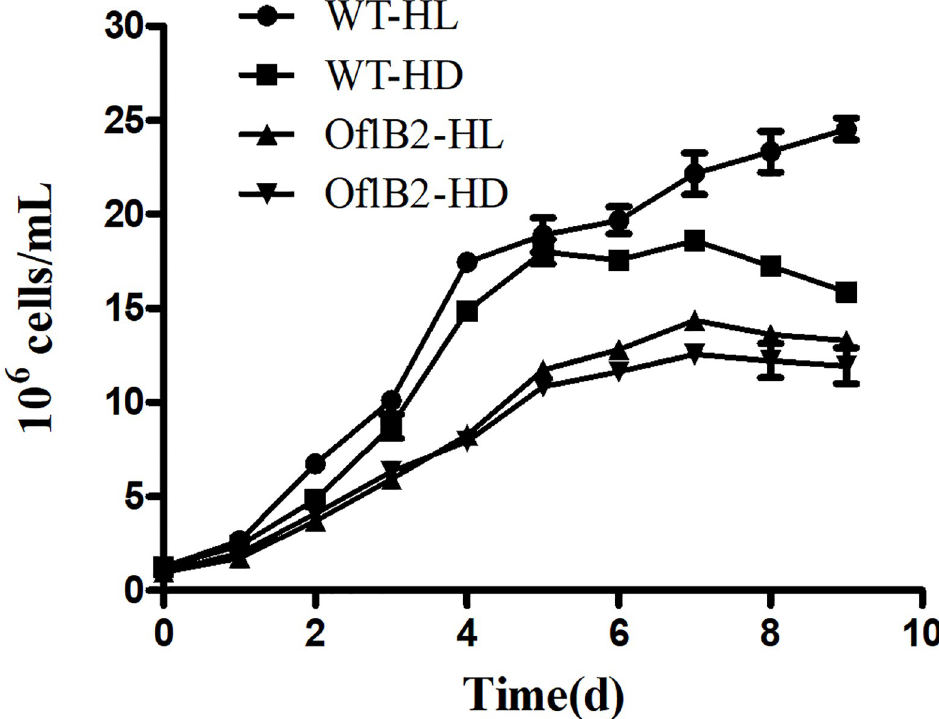
Fig 1. The growth of WT E . gracilis and OflB2 in Hetero medium under light (HL) and dark (HD) conditions.